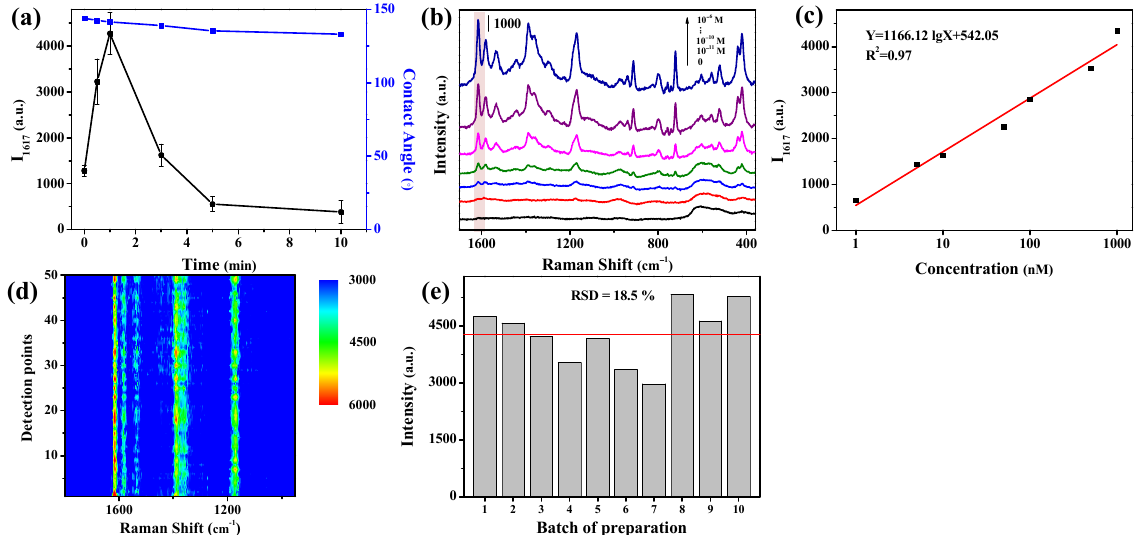
Figure 4. SERS performance of the Cu-Ag chip. ( a ) Effects of the replacement time of sliver on the peak intensity of CV at 1617 cm − 1 and the contact angle of the chip surface. ( b ) SERS spectra of CV at various concentrations on the Cu-Ag chip. ( c ) A plot of peak intensity of CV at 1617 cm − 1 on the Cu-Ag chip against CV concentration. Reproducibility of SERS signals obtained on the ( d ) intra-batch and ( e ) inter-batch Cu-Ag chips.